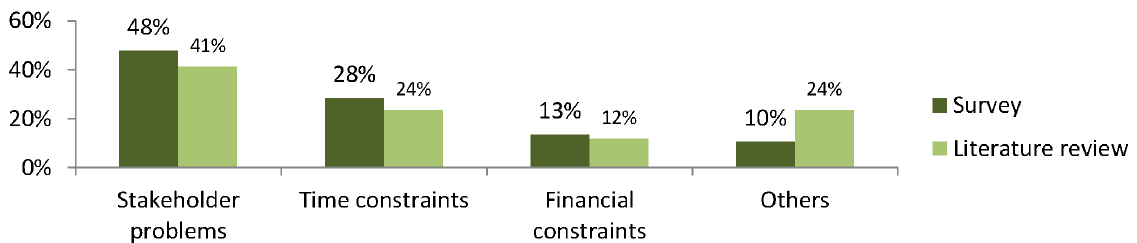
Figure 7: Overall challenges of stakeholder participation (survey: 67 mentions; literature review: 17